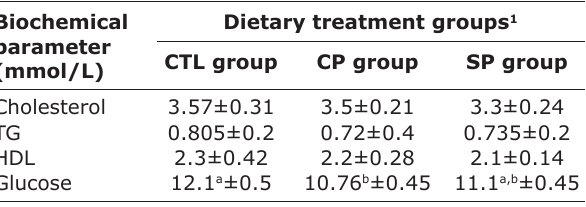
Table-5: Cost-benefit analysis of dietary probiotic